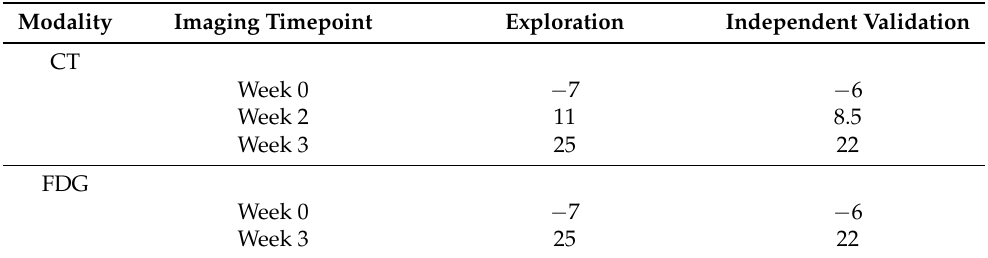
Table 1. Median elapsed time of recording of imaging data relative to the start of therapy in days.